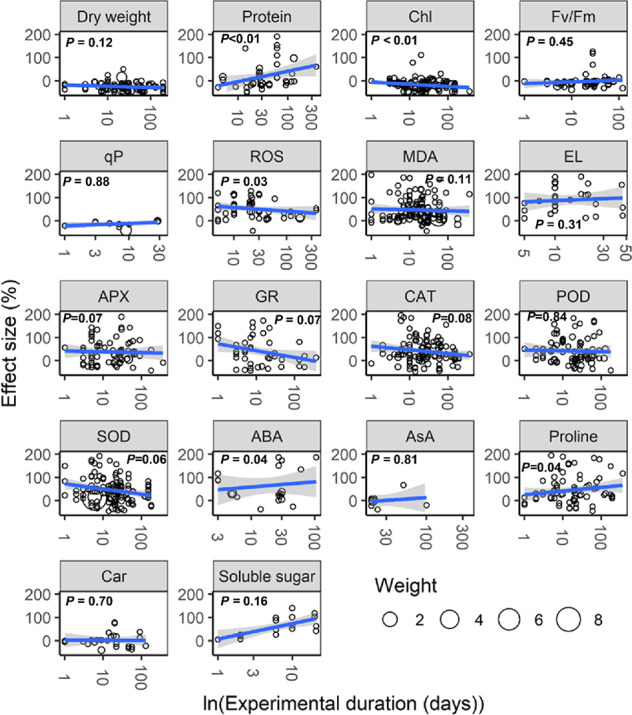
Responses of plant physiological indices to experimental duration. Linear regressions (blue lines) and their 95% confidence intervals (shaded areas) and corresponding levels of significances (P values) are presented. Circle sizes are proportional to the sampling variances. See 
Figure 1
 for abbreviations.